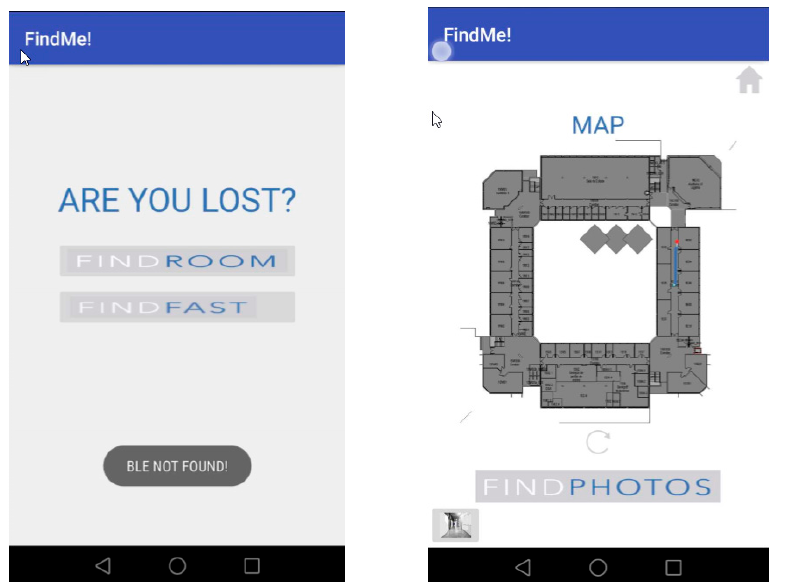
Figure 17. Test 3—at the starting point with no beacon signal ( Left ) and when a beacon is intersected, location is acquired, and guidance process